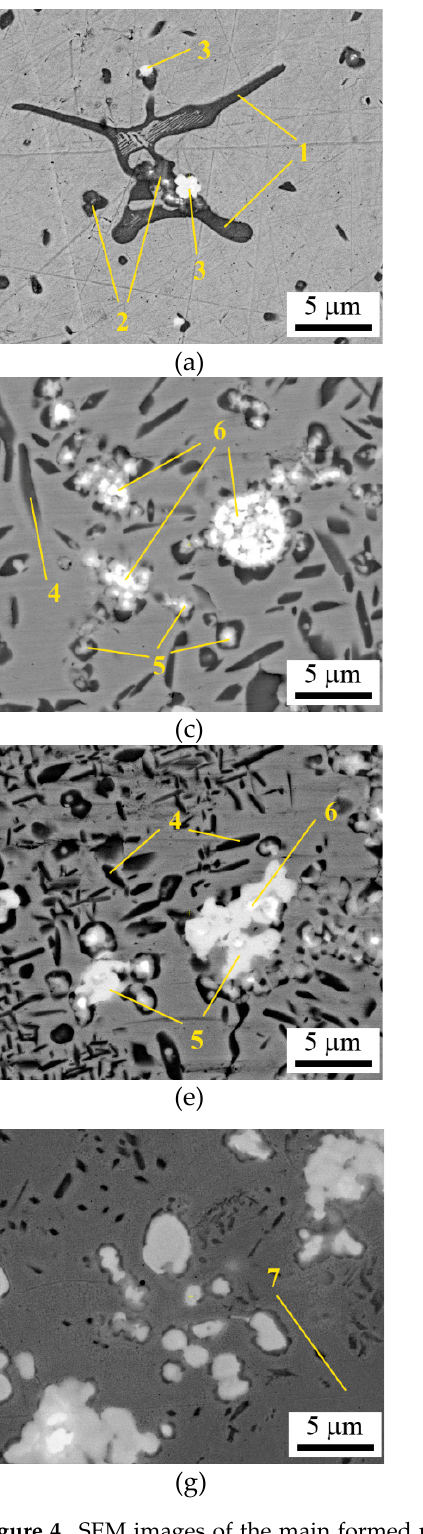
(f) Figure 5. Chemical element distribution maps of a 25%Ni sample showing the main types of parti- cles formed in the 3D-printing process of the bronze/Inconel multimaterial: ( a )—SEM image, ( b – f )—chemical element concentrations. Because the aluminum bronze matrix is enriched with nickel and other elements of the Inconel 625 alloy when 50% of it is added, the structure undergoes significant changes